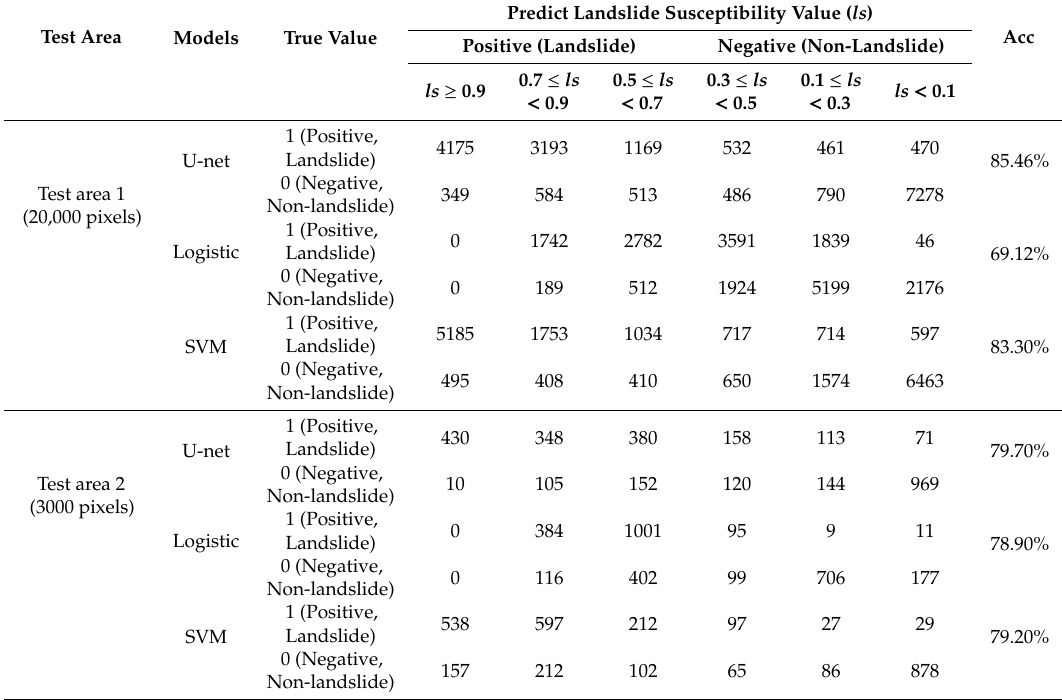
Table 5. Confusion matrix between predicted value and true value in test area 1 and 2 based on di ff erent